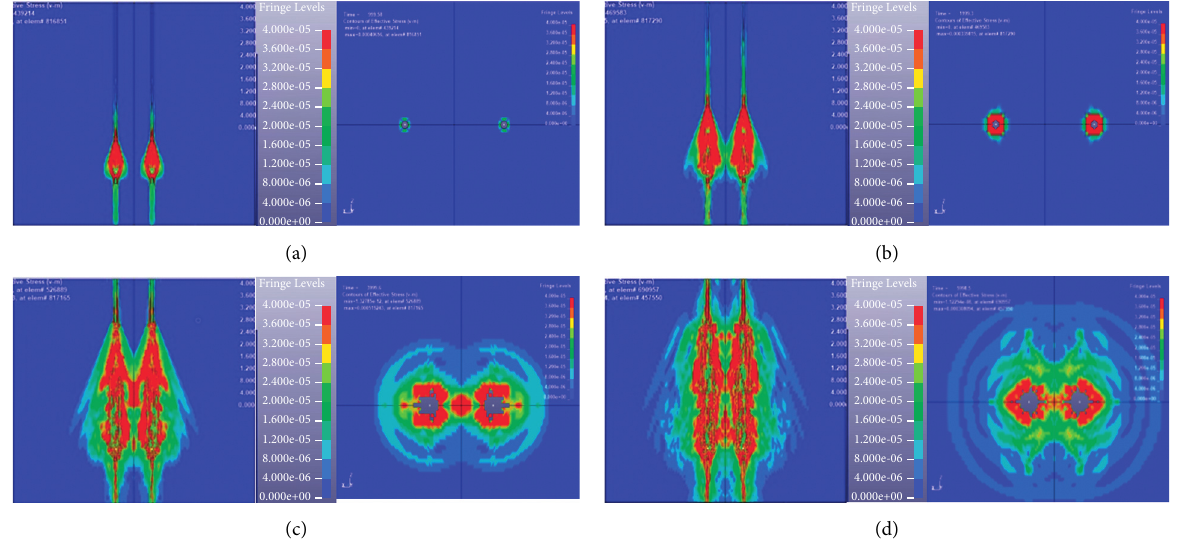
Figure 14: Stress nephograms of prone section and lateral section of anhydrous bag-accumulator smooth blasting (unit: 10 5 MPa). (a) T � 1.00ms. (b) T � 2.00ms. (c) T � 4.00 ms. (d) T � 6.00ms.